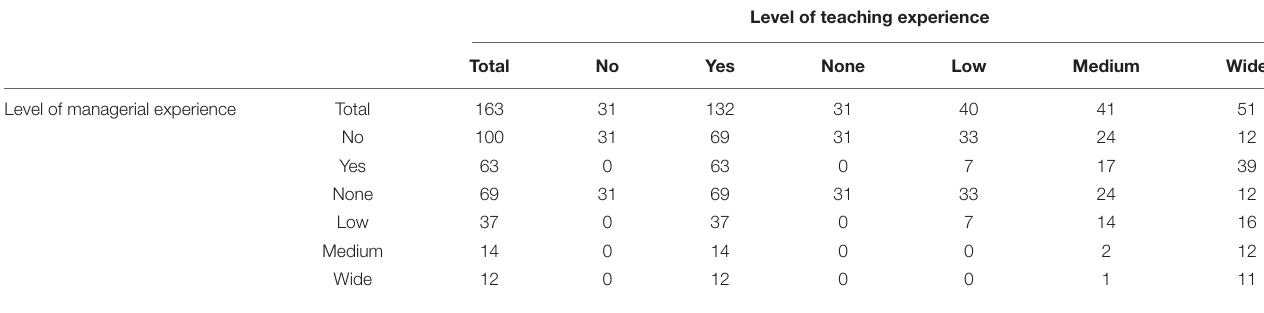
TABLE 1 | Distribution of participants by levels of teaching and managerial